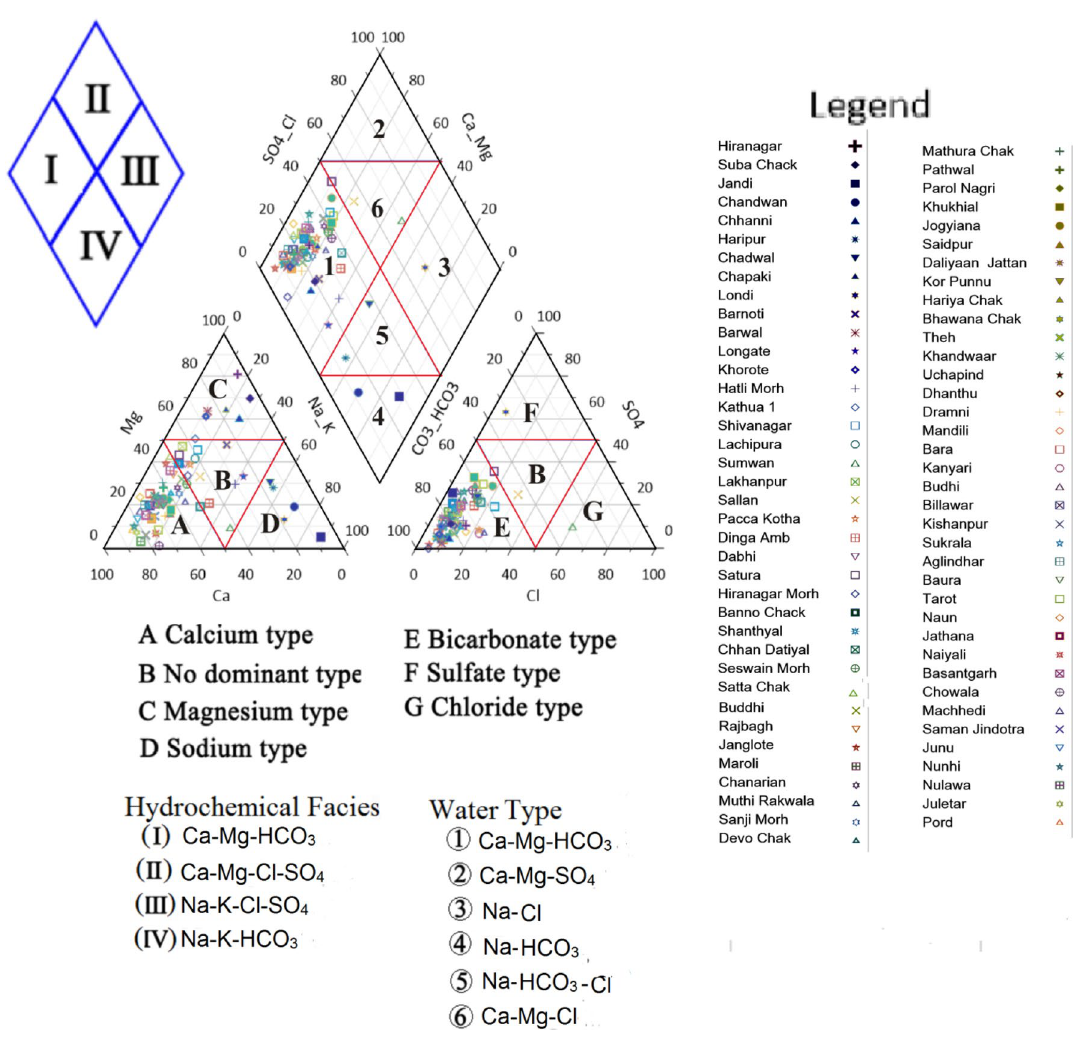
Fig. 3 Piper Trilinear diagram showing geochemical classification of